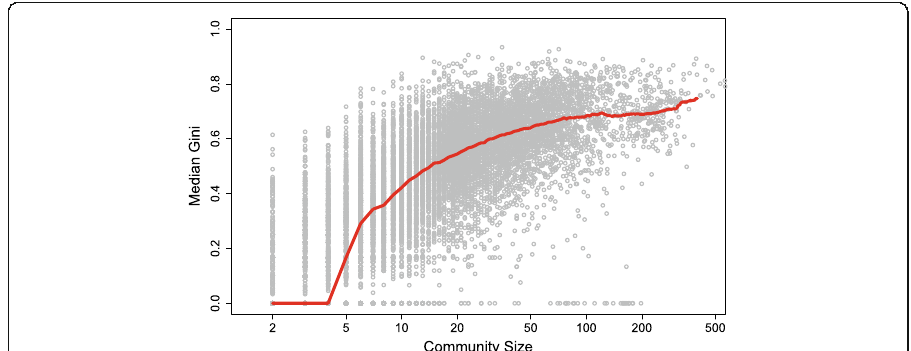
Fig. 1 The median Gini coefficient of online communities degree centrality as a function of the size of the community. Community lifetime was divided into 60 days windows. Size and Gini were calculated for each time window